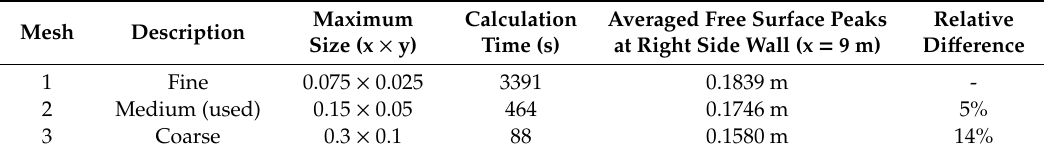
Table 1. Grid dependence of the free surface elevation at the right side wall under the Imperial Valley (IV) earthquake.